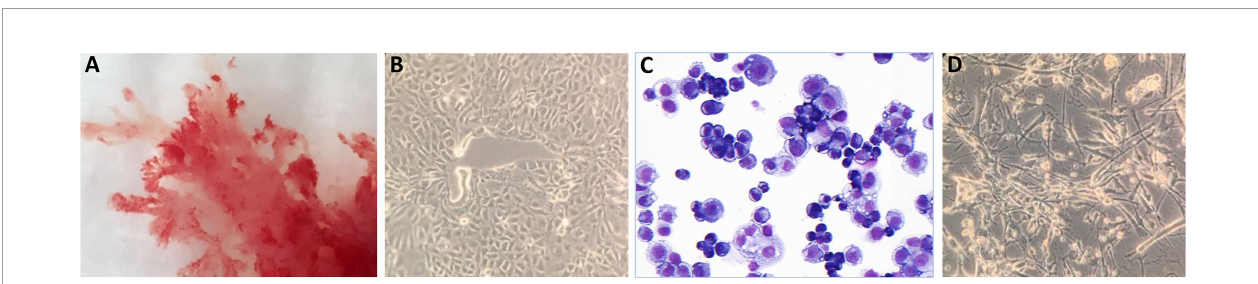
FIGURE 1 | Macroscopic and microscopic pictures of trophoblast cells. (A) Cultured trophoblasts from a representative experiment (donor QH1) are shown. CTB were evaluated by (B) light microscopy or (C) after May Grunwald-Giemsa staining. The cells form a dense cluster, are rounded in structure and adhere to the plate. (D) Cells at the EVT stage have a more spindle-shaped